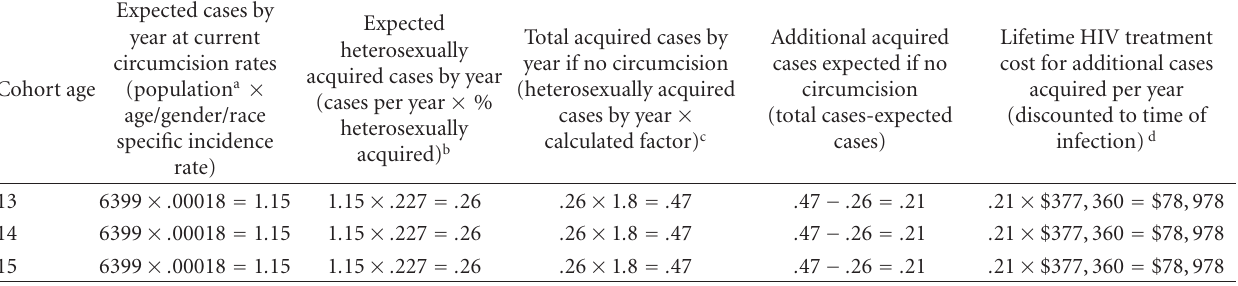
a 2009 SC medicaid birth cohort—black male population. b CDC HIV surveillance report statistics on diagnosis of HIV infection by race/ethnicity, gender, and transmission category (22.7% of black male HIV infections were reported as heterosexually transmitted). c See Table 3 for explanation of factor calculation.